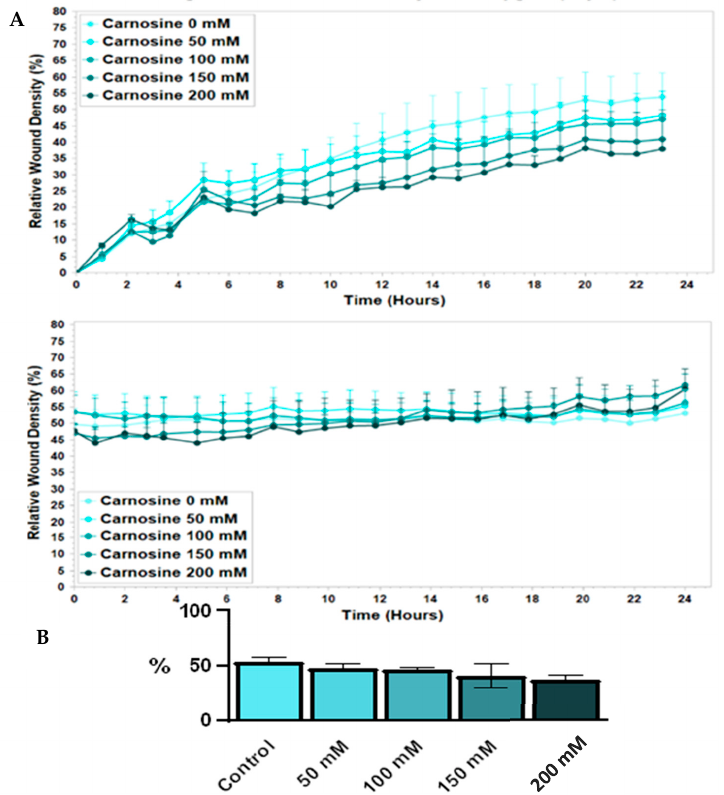
Figure 9. Effect of carnosine concentration on U87 cells’ wound healing by migration after ceasing their proliferation with mitomycin C. Cells were imaged in a 96 well plate while growing in media with different carnosine treatments using the IncuCyte S3 live cell imaging system to take two snaps per well each hour, ( A ) during the first day, when the relative wound density was analysed by the integrated IncuCyte wound scratch software and plotted against the elapsed time in hours. After 18 h of adherence, the scratch was applied, then mitomycin C was added after an hour. The carnosine treatment was applied at different concentrations and the plate was placed inside the IncuCyte device to start the 0 h image after about half an hour. All variations in cell growth were initiated after about 4 h. ( B ) The statistical analysis shows a slight increase in cell mobility caused by carnosine at a cell density of 10 3 per well.